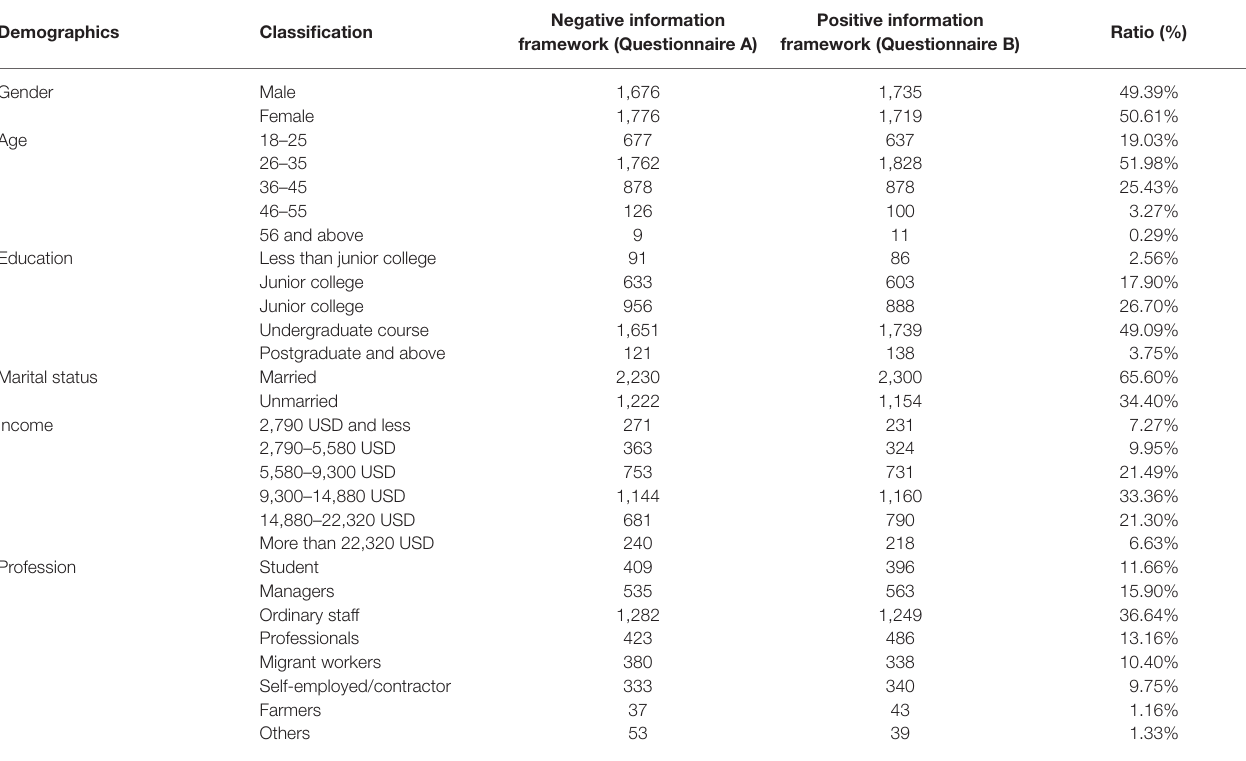
TABLE 1 | Demographic characteristic of participants.